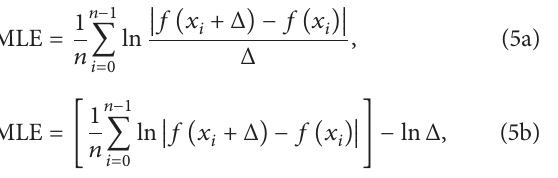
nearby initial points. Two suggested methods for calculating MLE in finite precision are explained in the next two